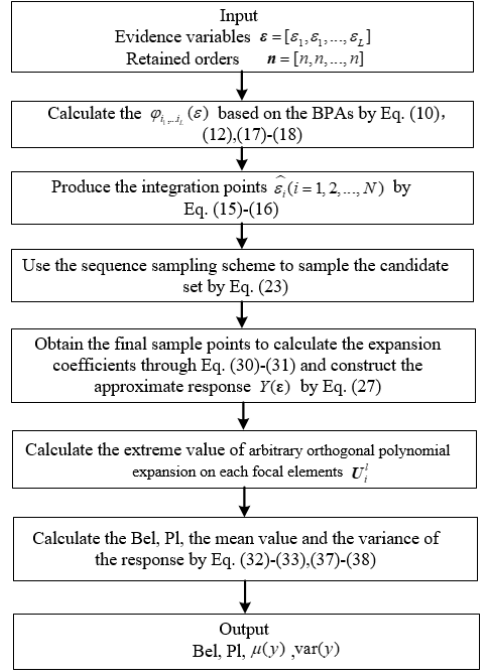
Figure 2. Flow chart of the proposed SS-AOP for the evidence theory model.